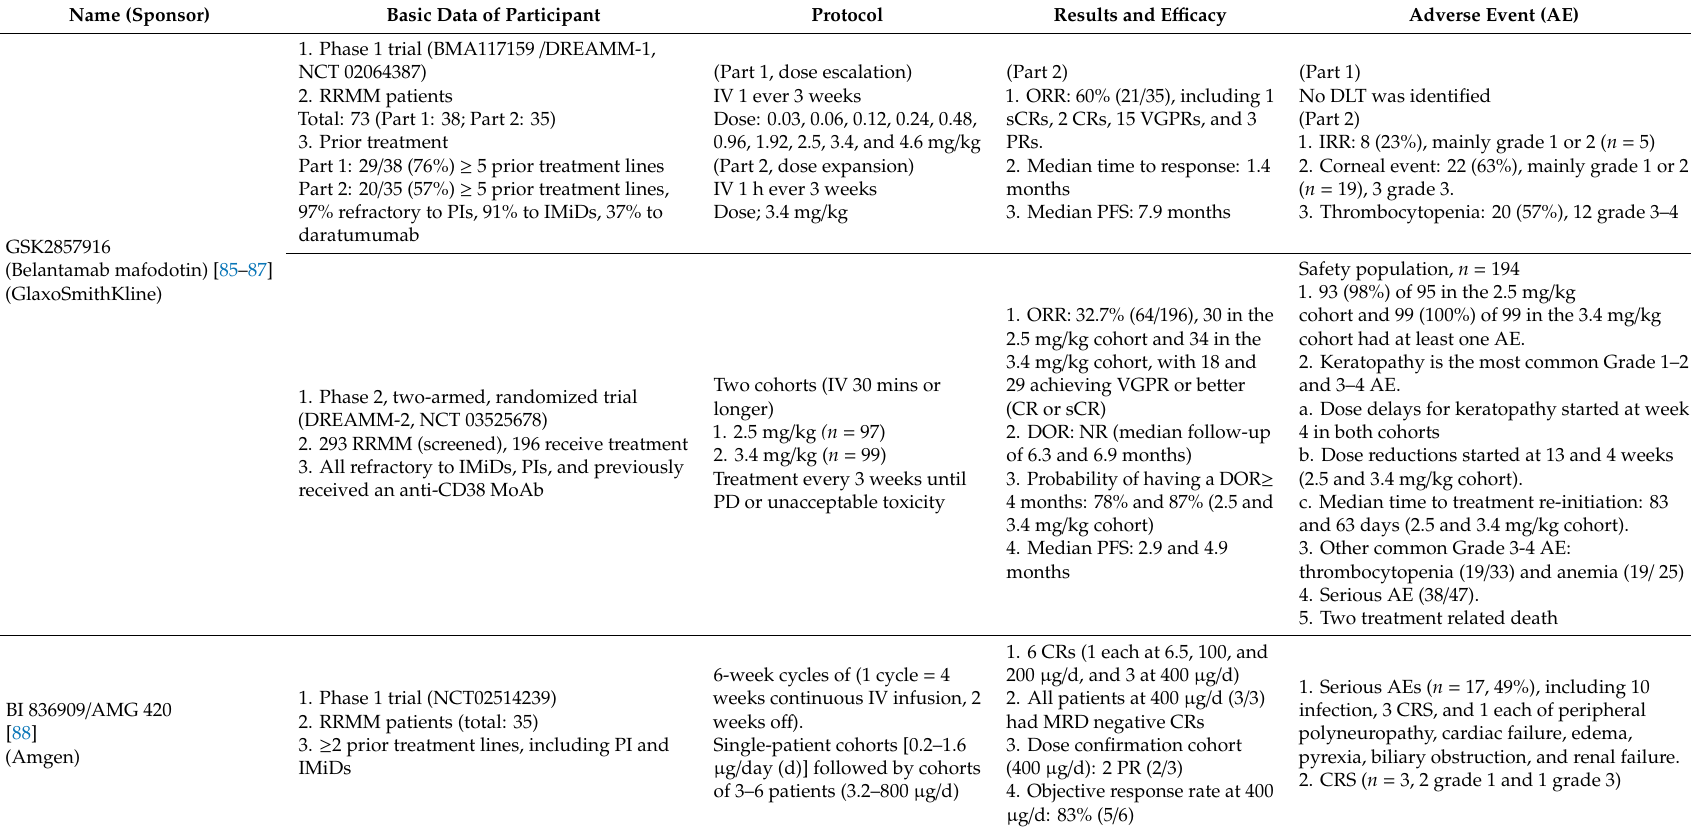
Table 2. Summary clinical study results of anti-BCMA ADC, BiTE, and bispecific